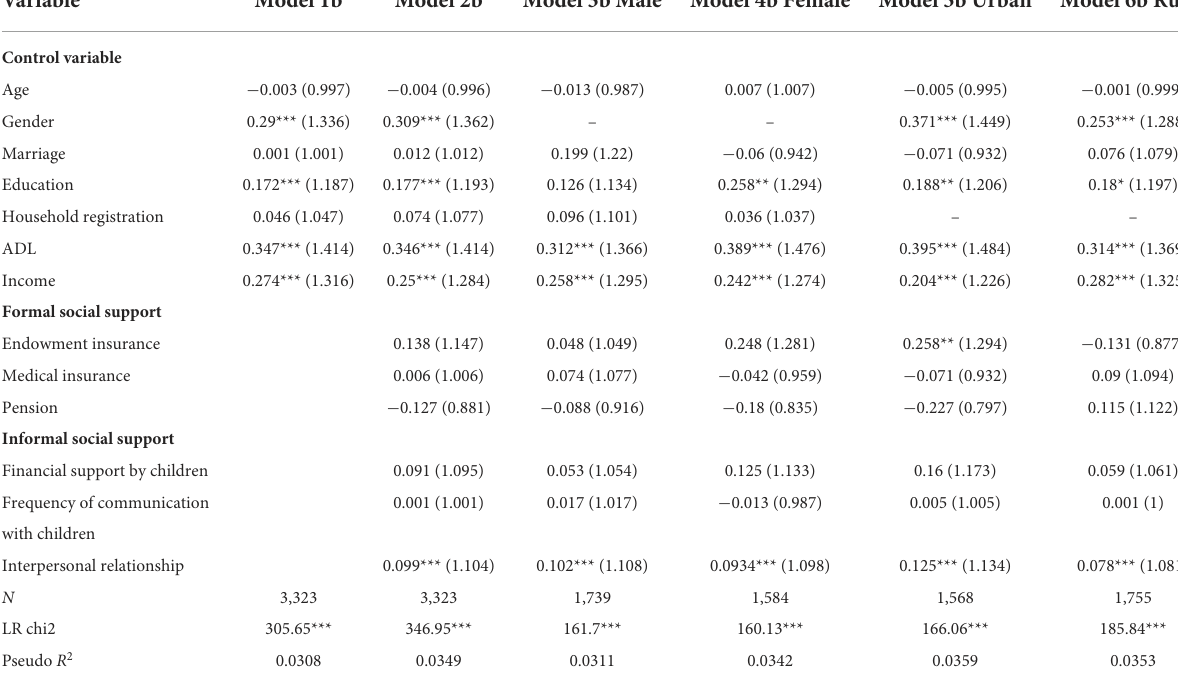
TABLE 3 The impact of formal and informal social support on self-rated